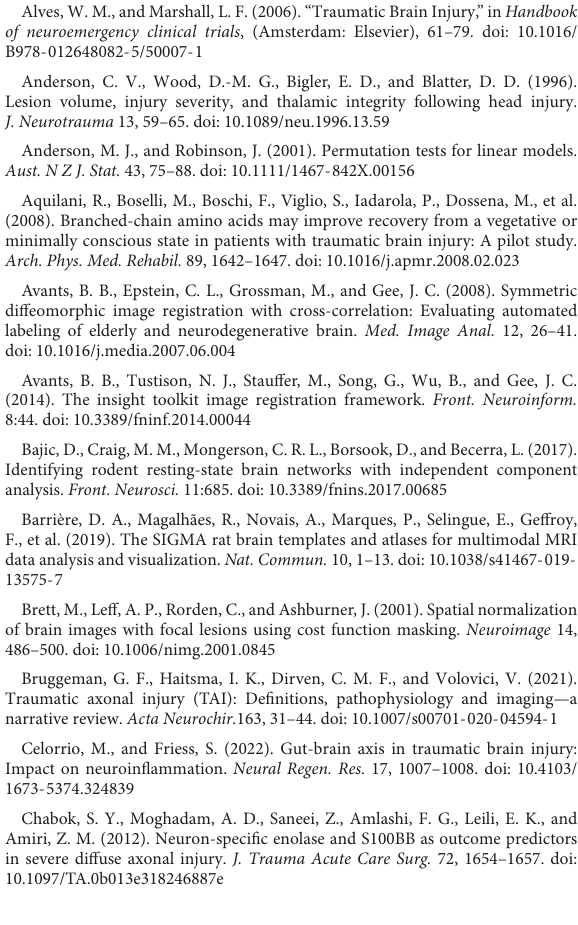
SUPPLEMENTARYFIGURE1 Results of principal component regression analyses predicting (A) neurite density index (NDI) and (B) isotropic diffusion fraction (fISO) from the first independent component (IC) of the amino acid panel at day three post-injury and (C) NDI from the first IC of the amino acid panel at day seven post-injury. (D) Spatial maps of the regions-of-interest (ROIs) used for quantification of NODDI metrics from the internal capsule (red), ipsilateral cortex (green), and ventricles